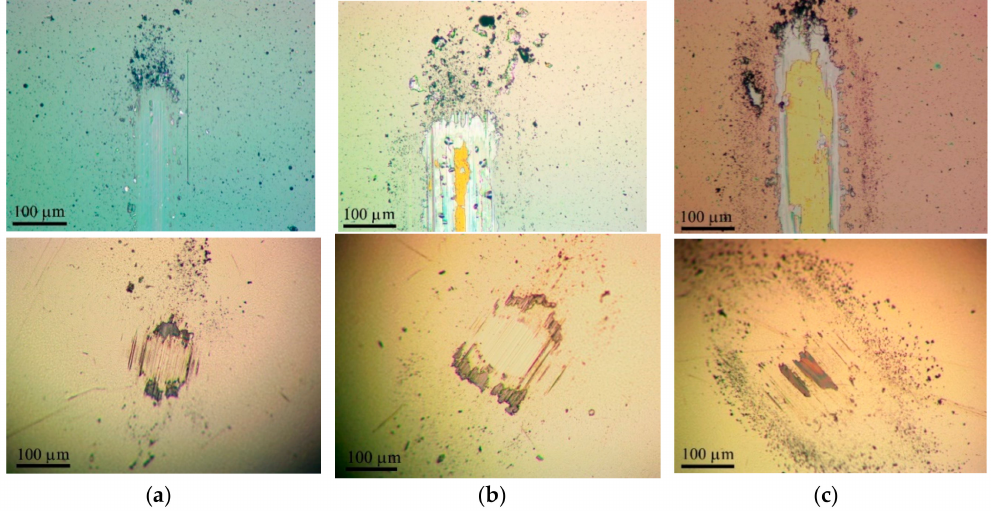
Figure 11. Optical images of wear tracks and wear scars formed on the steel substrates and steel balls for the Mo-S-C-H thin-film coatings obtained by reactive PLD at the di ff erent pressures of H 2 S gas: ( a ) 5.5, ( b ) 9, and ( c ) 18 Pa. Pin-on-disk tribometer testing was conducted in dry friction conditions (air + Ar mixture, RH ~8%) at 22 ◦ C. The test durations are indicated in Figure